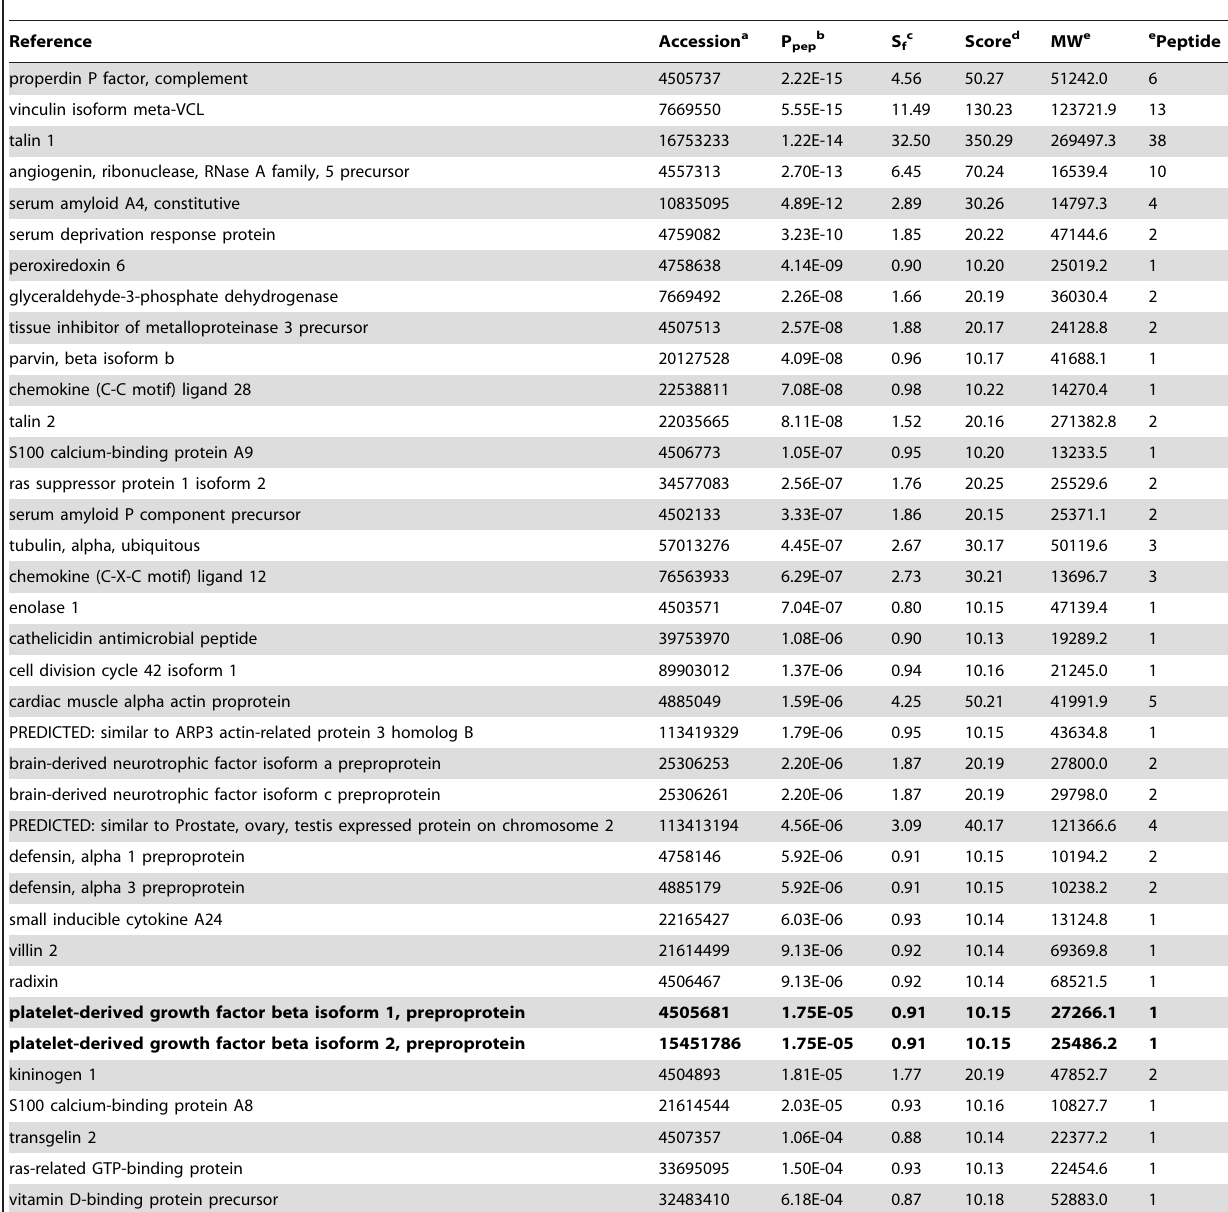
Table 2. Native PDGF was found in healthy donor serum purified by core shell particles and measured by nano reverse phase liquid chromatography mass spectrometry